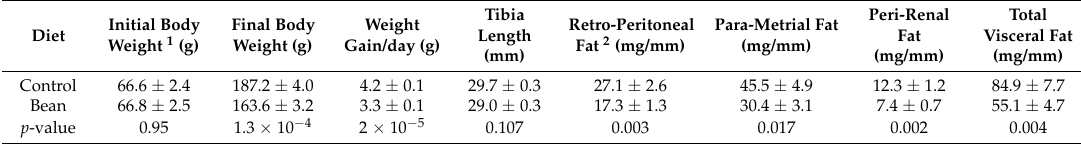
Table 2. Effect of ad libitum feeding of commercially processed bean powder on weight gain and visceral